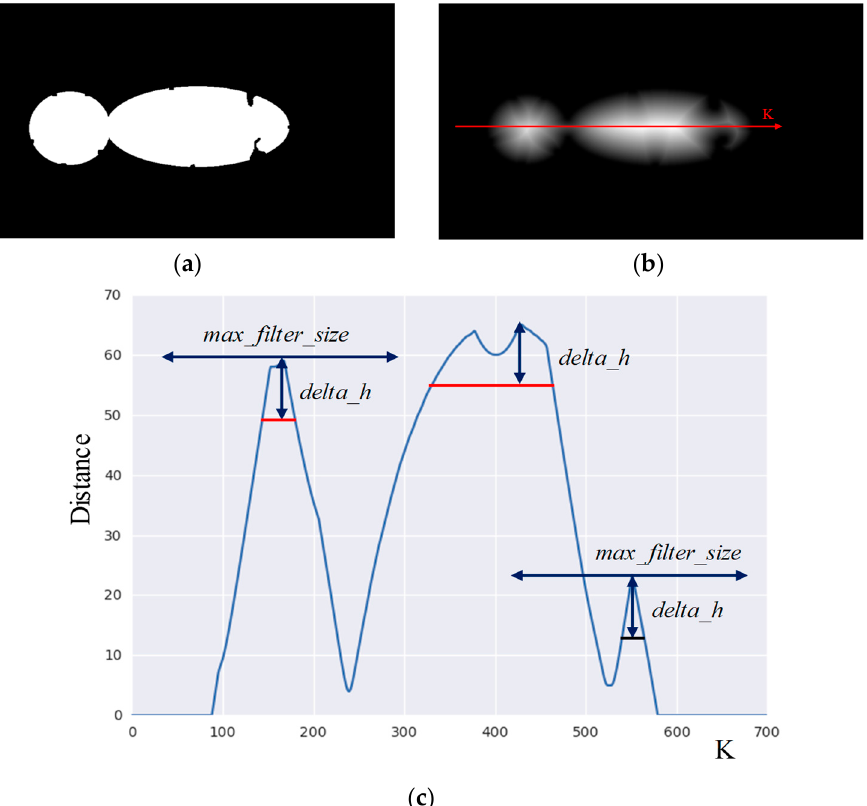
Figure 7. Illustration of parameters for generation of markers. ( a ) binary image; ( b ) distance map; ( c ) profile of intensity along K axis.